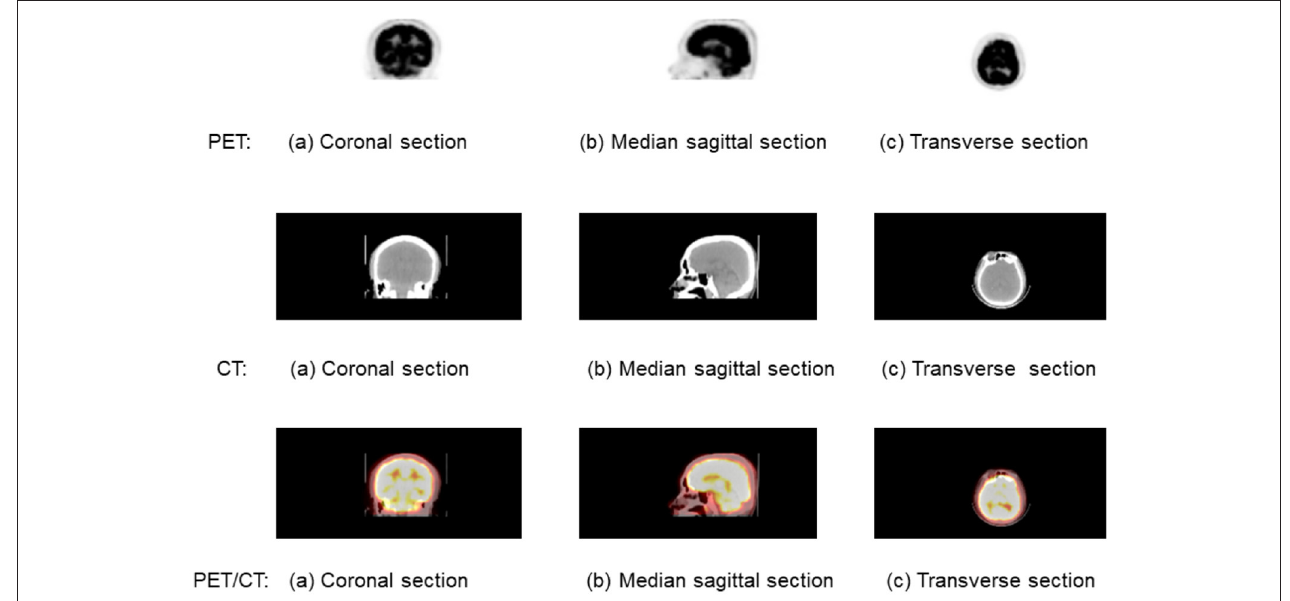
FIGURE 1 | A brain positron emission tomography (PET)/computed tomography (CT) fusion image. The first line is the PET imaging, and the second line is the CT imaging. The fusion imaging of PET/CT is list in the third line. Each line from left to right is (a) coronal section, (b) median sagittal scan, and (c) transverse section.